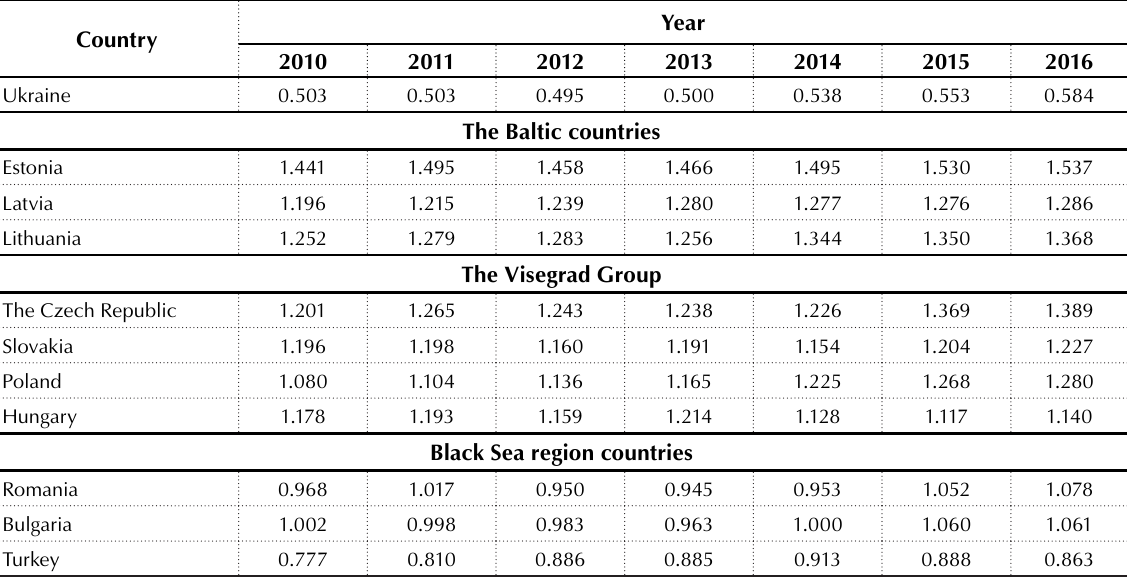
Table 2. Integral indicator of business environment